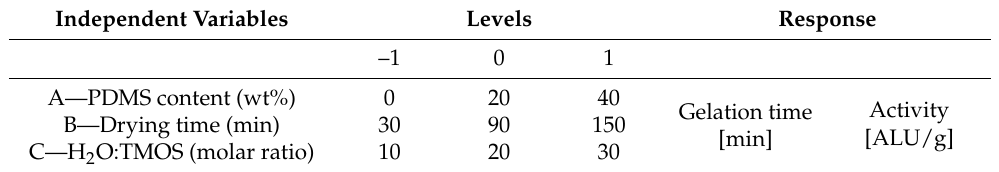
Table 4. Levels of variables and studied responses in the Box–Behnken design experiment. Independent Variables Levels